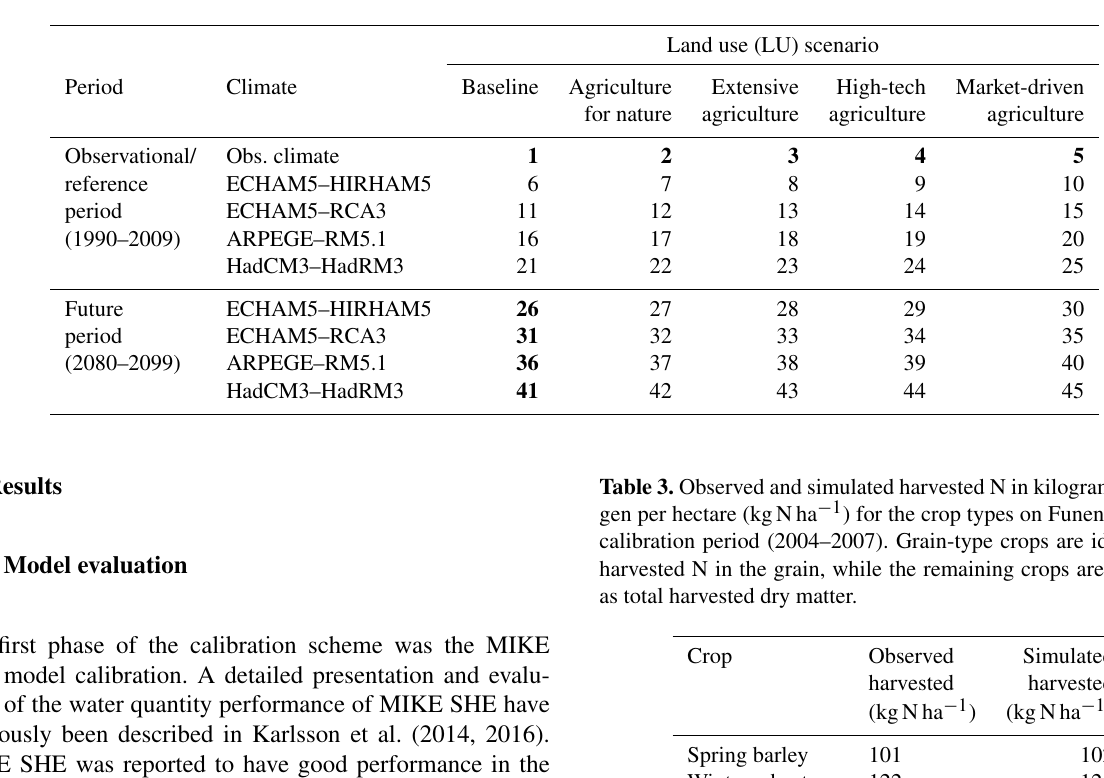
Table 2. Land use and climate scenario matrix showing the scenario numbers. Scenarios highlighted in bold indicate the scenarios chosen for illustration in Figs. 3, 4, and 6–8 and the baseline scenario.